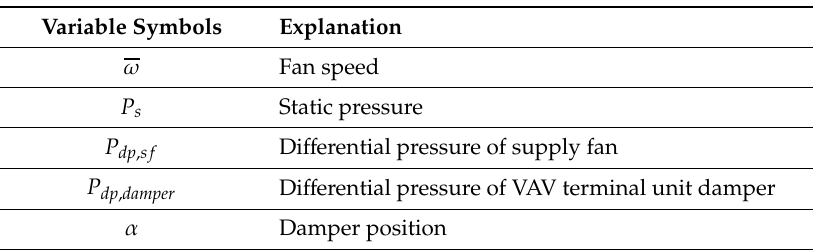
Table 3. Summary of variables.